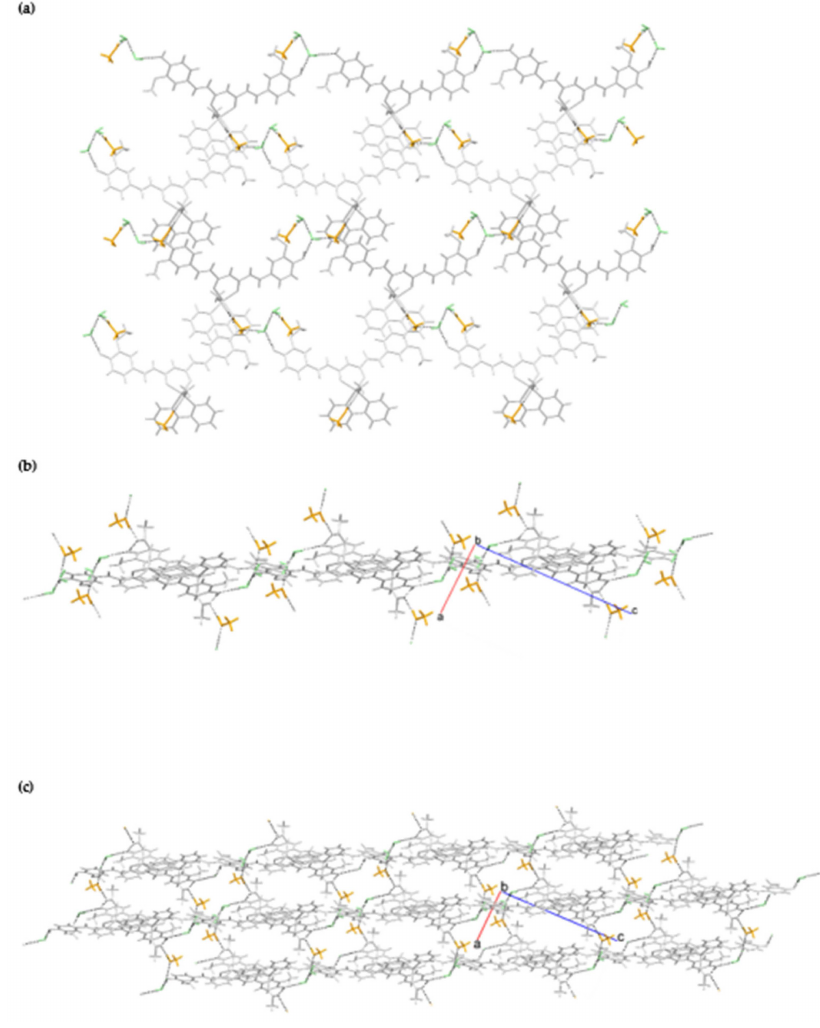
Figure 7. Hydrogen-bonding in [Zn(CH 3 COO)(cur)(bpy)]( 1 ) · CH 3 OH · 2H 2 O: ( a ) A perpendicular view of the layer. ( b ) A view along the layer. ( c ) Stacking of layers with the agency of methanol linkers. Color code: light grey = [Zn(CH 3 COO)(cur)(bpy)]( 1 ) molecules, orange = methanol, and green = water